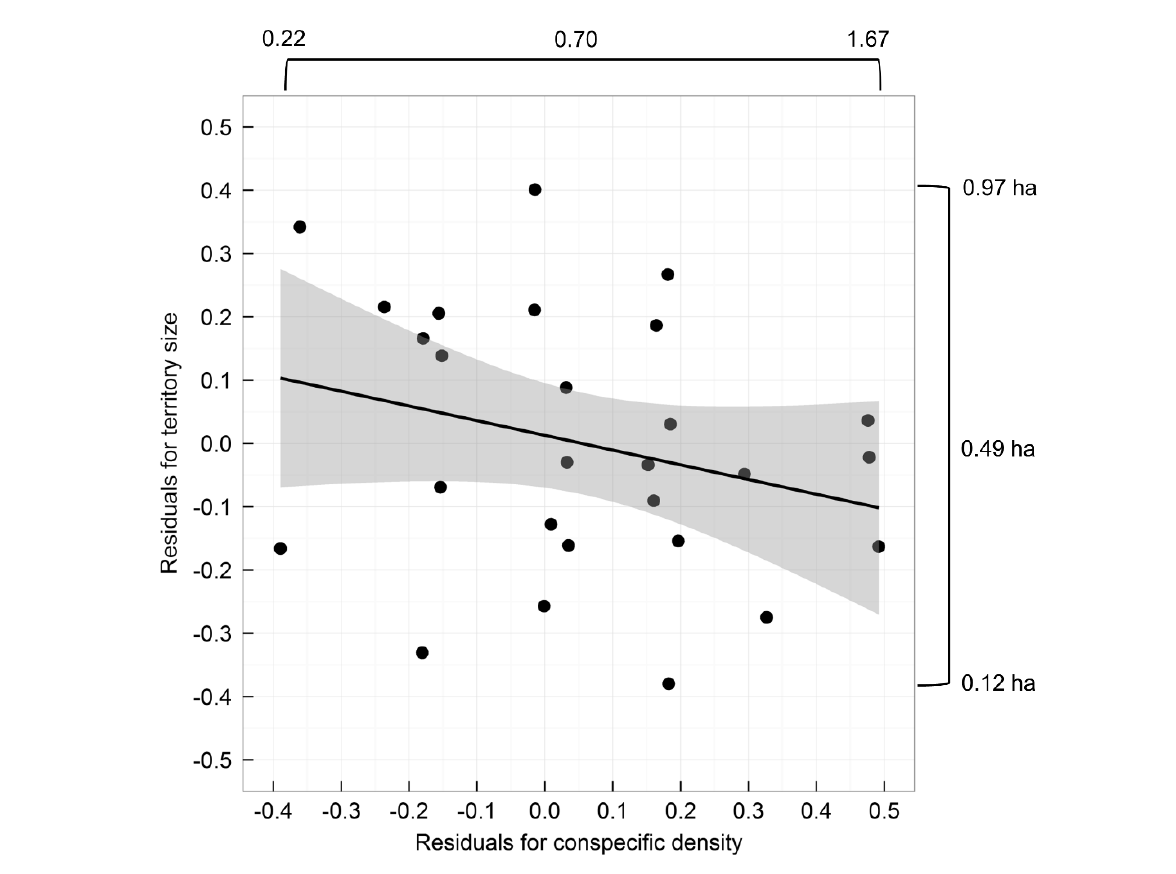
Figure A1.2. Partial residual plot illustrating relationship between conspecific density and territory size. The grey area represents the 95% confidence interval associated with the fitted values. The bracket on the top, from left to right, illustrates the minimum, median, and maximum conspecific density, respectively. The bracket on the right, from top to bottom, illustrates the maximum, median, and minimum measurements for territory size (ha; 50% KDE contour),